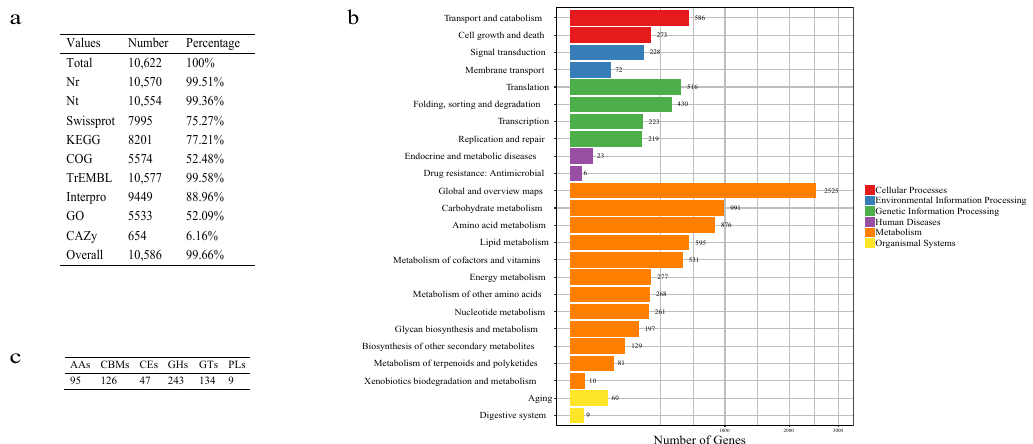
Figure 2. Function annotation of strain P. variabile HXQ-H-1 ( a ). Statistics of annotated genes by 9 databases. The third column indicates the ratio of the annotated genes number. ( b ). KEGG pathway classification. Histograms represent the gene number of pathways and grouped into 6 classifications which were tagged by colors. ( c ). Gene numbers of annotated by